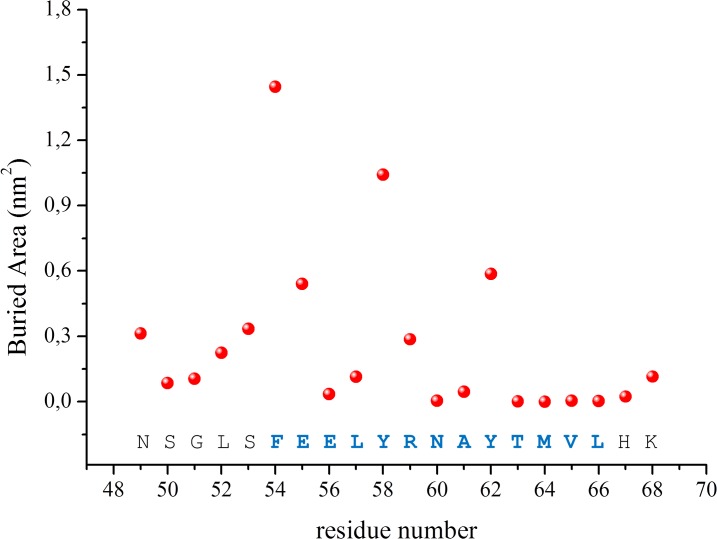
Buried area of Cul349-68 residues upon complex formation with KCTD11BTB.